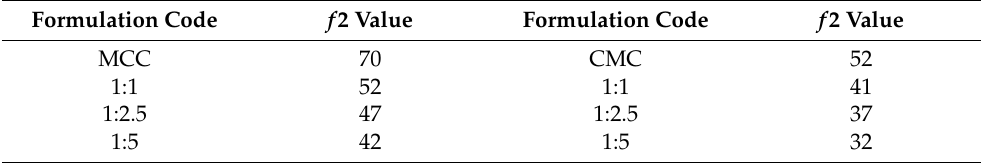
Figure 7. In vitro drug release profiles of ( a ) MCC and MCC-SiO 2 conjugates FDTsand ( b ) CMC and CMC-SiO 2 conjugates FDTs. Table 8. Values depicting f 2 values obtained from the in vitro dissolution studies of the formulated MCC-SiO 2 FDTs and CMC-SiO 2